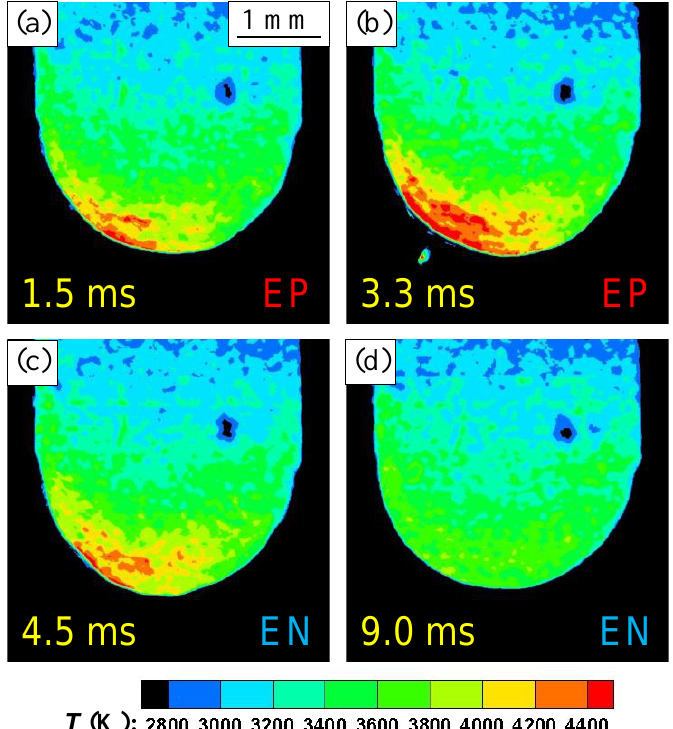
Figure 11. Two-dimensional distribution of the electrode surface temperature during 1 AC cycle: ( a ) t = 1.5 ms; ( b ) t = 3.3 ms; ( c ) t = 4.5 ms; and ( d ) t = 9.0 ms.